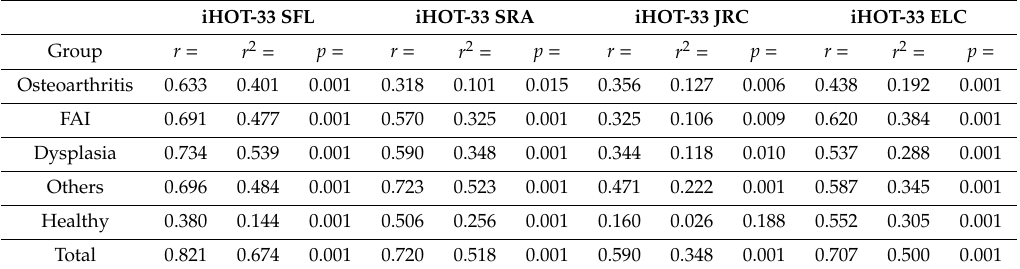
Table 3. Correlation coe ffi cients ( r ) and r 2 of the SHV and the subitems of the International Hip Outcome Tool (iHOT-33). SFL = symptoms and functional limitations, SRA = sports and recreational activities, JRC = job-related concerns, SELC = social, emotional and lifestyle